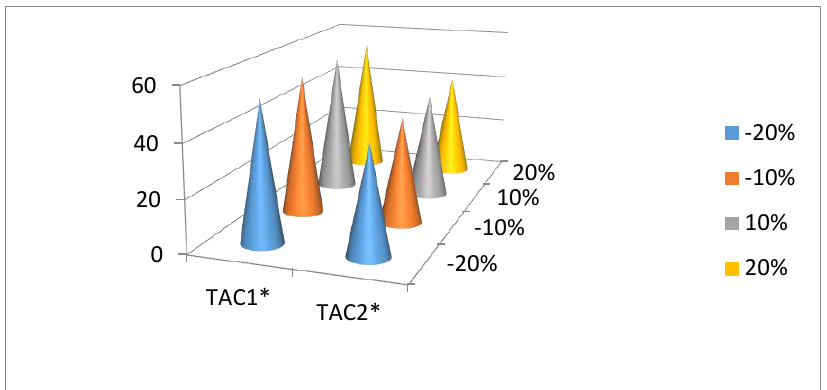
Fig. 7. Minimizing cost of both items for different values of 𝜌 1 , 𝜌 2 .